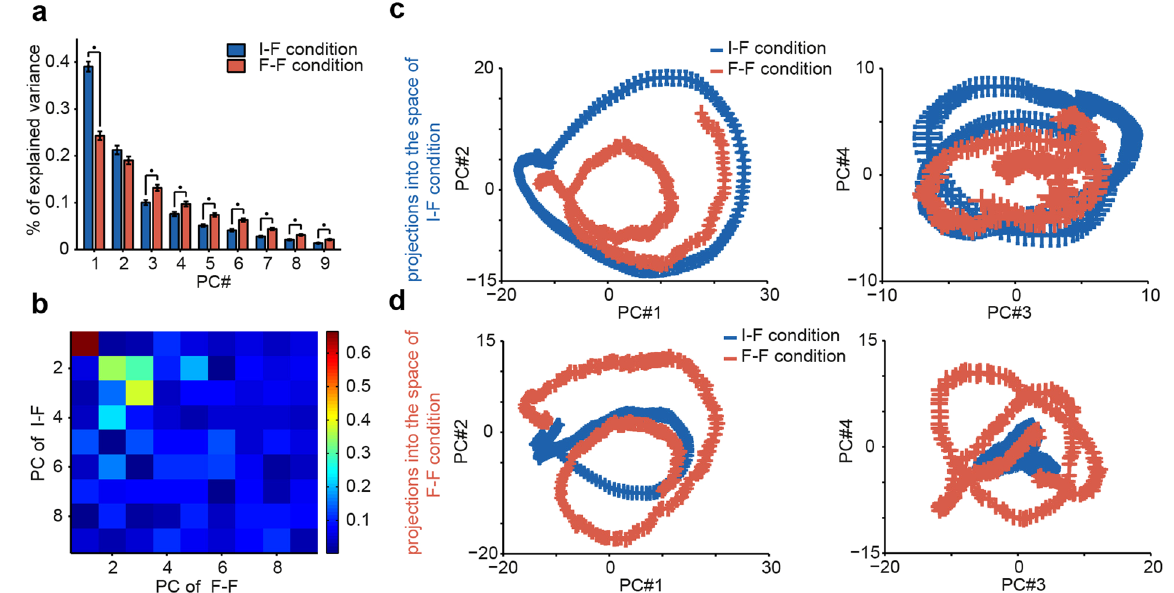
Figure 5. Principal components (PCs) of the network and difference between the adaptation and non- adaptation conditions. PCs—eigenvectors—of the network’s mean activity under the non-adaptation (blue) and adaptation (red) conditions are extracted separately by PCA. ( a ) The percentage of explained variance by each PC in two conditions. The stars show the significance of differences using a z-test. ( b ) Rotation of PCs in two conditions are quantified by the absolute value of their pairwise dot product (cosine of the angle between eigenvectors). The rows and columns are representative of the eigenvectors of the non-adaptation and adaptation conditions, respectively. ( c , d ) The projection of the network response trajectory under the non- adaptation and adaptation conditions into the first four PCs of the two PC spaces: ( c ) the projections into the space constructed from the non-adaptation responses, ( d ) the projections into the space constructed from the adaptation responses. Red and blue curves show the projections of adaptation and non-adaptation responses into the spaces, respectively. In ( c,d ) the graphs on the left show the projections into PC1 vs. PC2, and the graphs on the right are the projections into PC3 vs. PC4. The error bars indicate